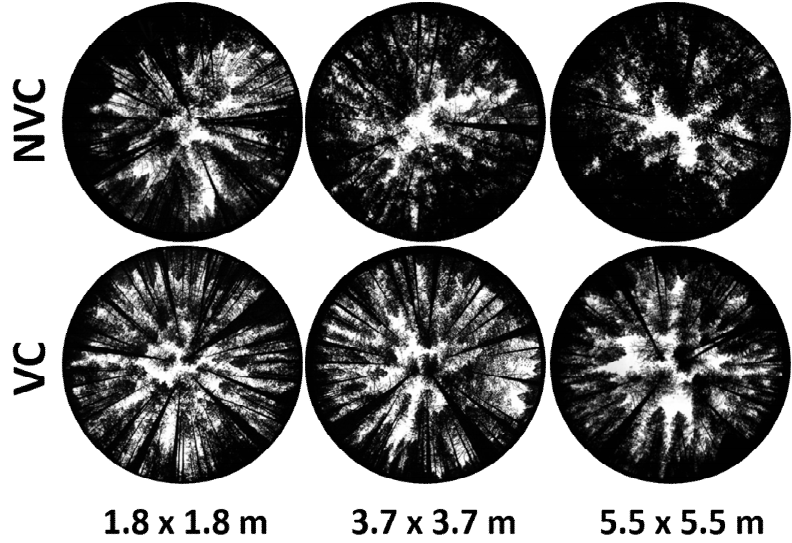
Figure 6. Example fisheye photos taken at age 54 from the center of each subplot under combinations of understory vegetation control (VC) and non-control (NVC) and three di ff erent levels of planting spacings at Challenge Experimental Forest, California, USA.